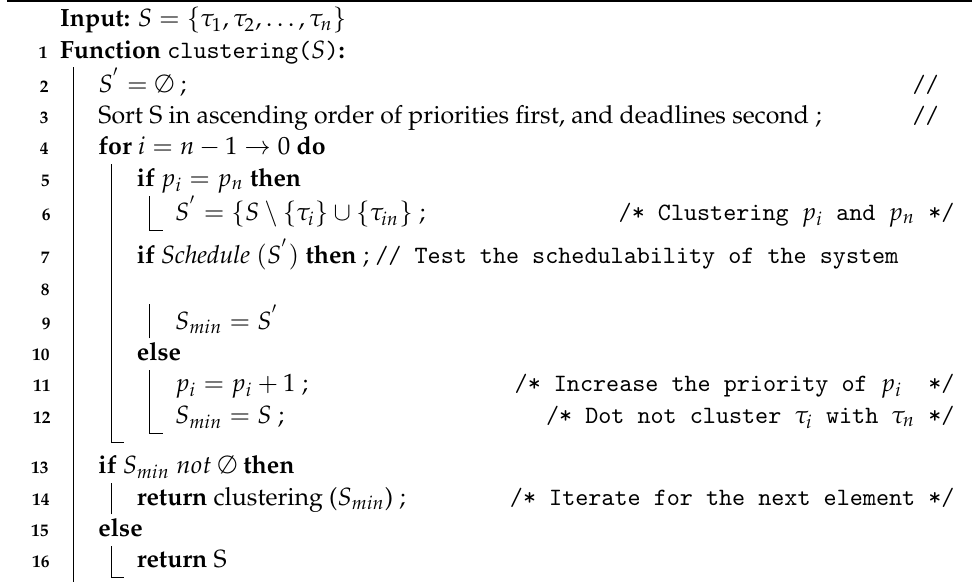
Algorithm 5: Rate monotonic scheduling (RMS)